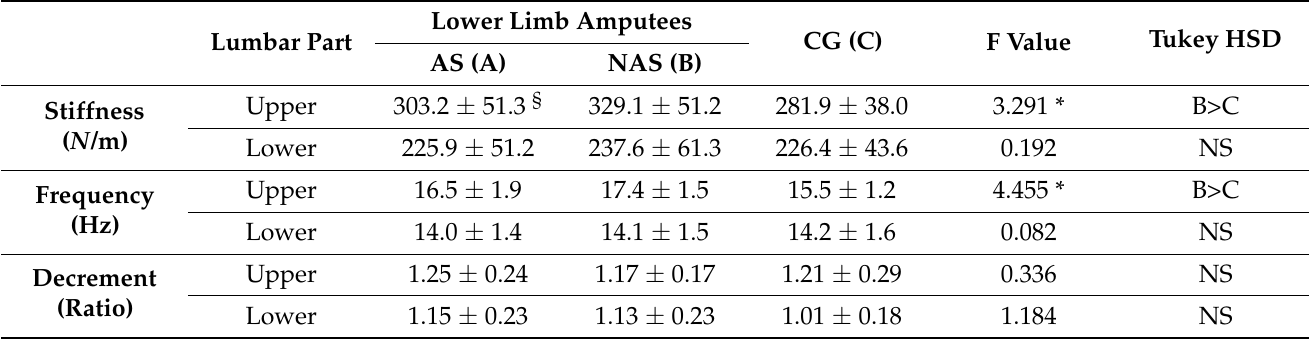
Table 4. Comparison of lumbar muscle properties in AS, NAS, and